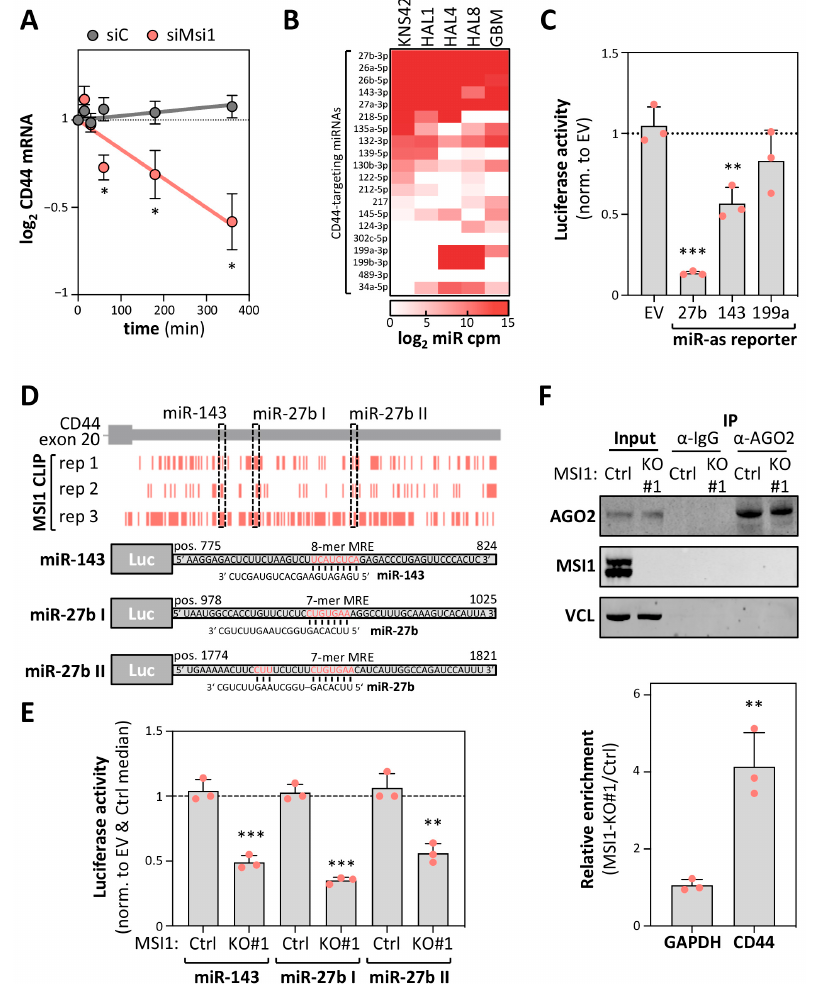
Figure 5. MSI1 impairs the miRNA-dependent downregulation of CD44 expression. ( A ) RT-qPCR analyses of CD44 mRNA decay in siC- or siMSI1-transfected KNS42 cells. RNA synthesis was inhibited by Actinomycin D (ActD; 5 µM) for the indicated time, 72 h post-transfection. Transcript abundance was normalized to the input levels. ( B ) Heatmap presentation of the expression of the indicated miRNAs (counts per million, cpm) in KNS42 cells, three individual isolated primary tumorspheres, HAL1, 4 and 8, and the primary GBM samples [35,36], analyzed via small RNA-seq. The 20 most abundant CD44-3 ′ UTR-targeting miRNAs in KNS42 are indicated, predicted by TargetScan [34]. ( C ) Luciferase activity of the reporters comprising the complementary sequence to the indicated miRNAs as 3 ′ UTR were determined in KNS42 cells. A reporter comprising the vector-encoded 3 ′ UTR (EV) served as the control. ( D ) Peak coordinates (upper panel) derived from MSI1 CLIP [12] and mapped to the genomic region encoding for the last CD44 exon are overlaid with miRNA-recognition elements (MREs) for the indicated miRNAs. Schematic presentation of the luciferase reporters (lower panel), comprising 48 nt of the indicated regions. Respective miRNA seed regions are highlighted in red. ( E ) Luciferase activity of the indicated reporters as in (D) were determined in Cas9-only transfected (Ctrl) or MSI1-deleted (KO) KNS42 cell clones. ( F ) Representative Western blot analysis of the indicated proteins (upper panel) and RT-qPCR of the indicated transcripts upon AGO2 co-immunoprecipitation in Cas9-only transfected (Ctrl) or MSI1-deleted (KO) KNS42 cell clones. VCL and GAPDH served as the loading and negative controls. Error bars indicate the standard deviation from three independent experiments. Statistical significance was determined by Student’s t -test (***, p ≤ 0.001; **, p ≤ 0.01; *, p ≤ 0.05; n.s., not